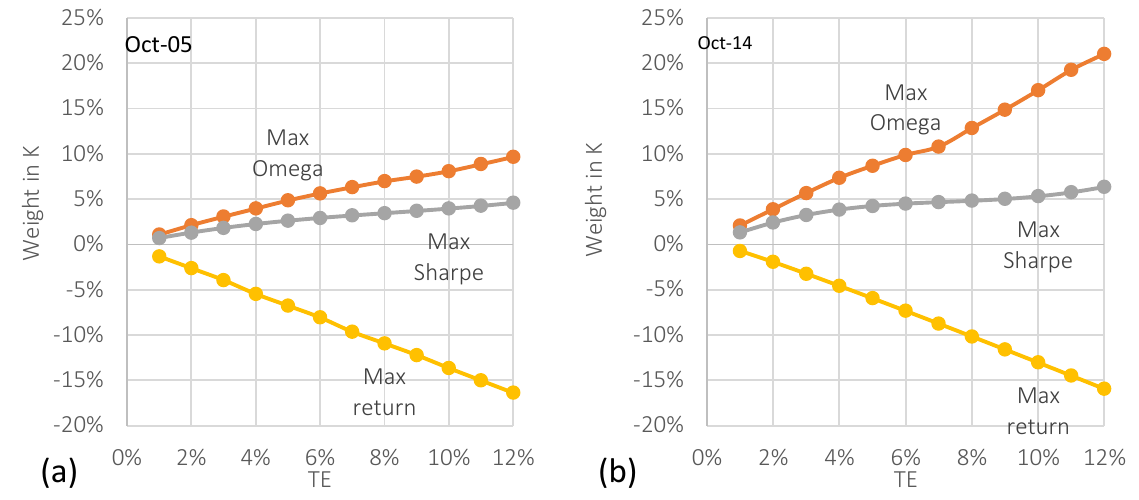
Figure 9. Asset K’s deviation in weight from the benchmark for the relevant portfolios in (a) Oct-00